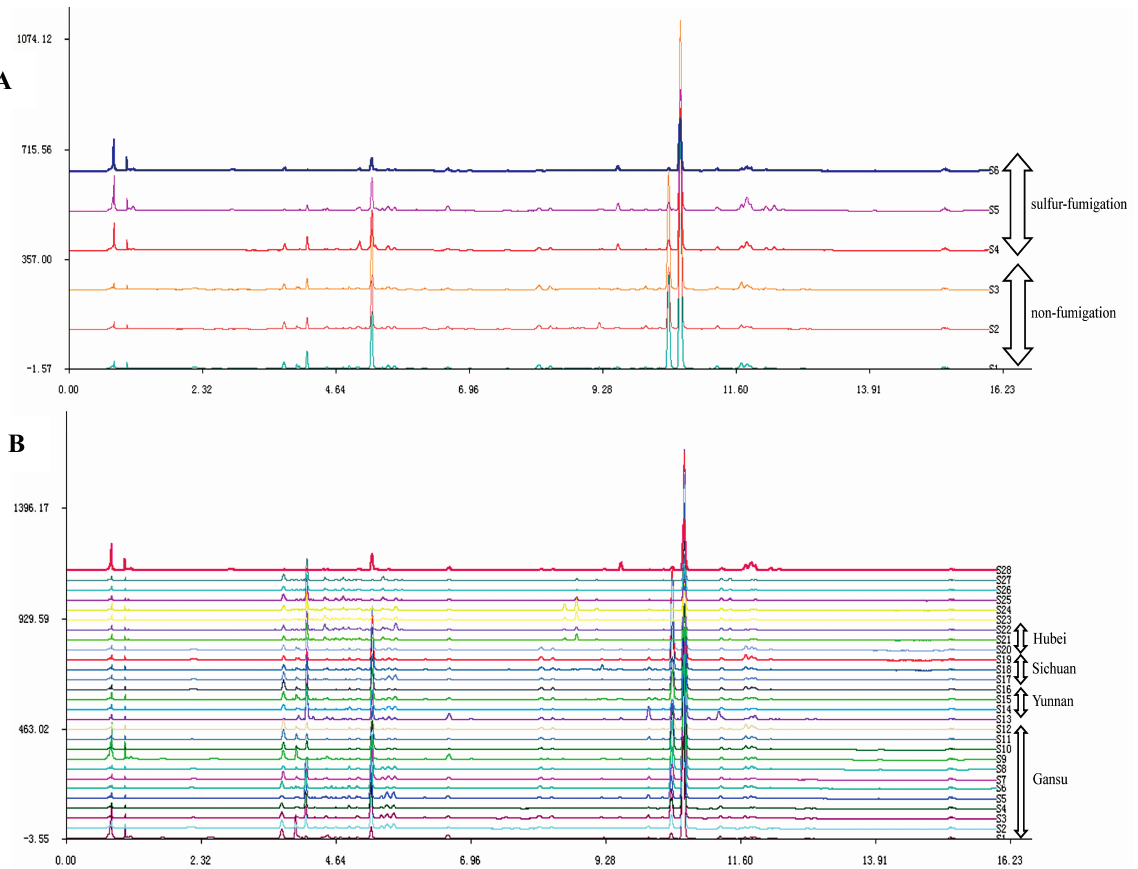
Figure 2. The fingerprint of non-fumigated and sulfur-fumigated Angelica sinensis ( A ) and Angelica sinensis from different regions ( B ) by UPLC. Peaks: (1) Ferulic acid; (2) Senkyunolide A; (3) n-Butylphathlide; (4)